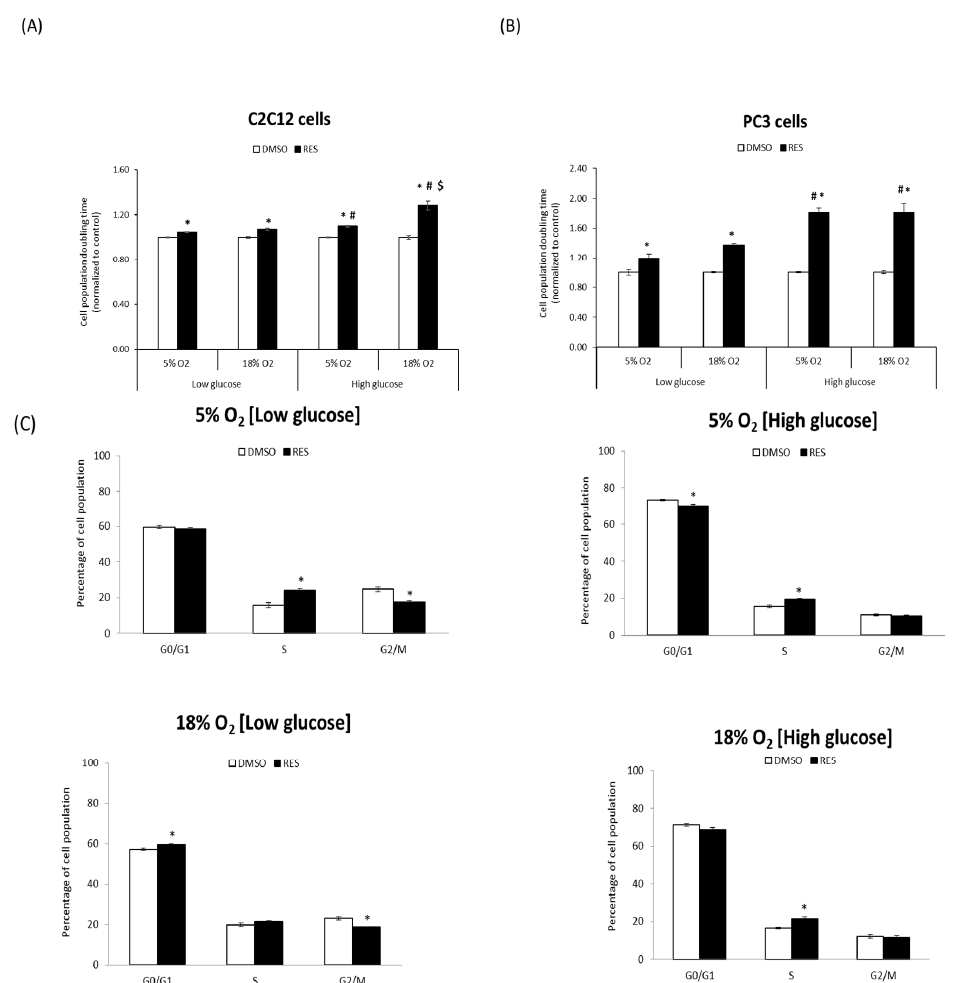
Figure 1. Media oxygen and glucose levels determine resveratrol’s effects on cell growth. Cell doubling time was measured following 48 h treatment with either Resveratrol (RES) (10 µ M; filled bars) or vehicle control (DMSO; open bars). C2C12 ( A ) and PC3 ( B ) cells were cultured at either 5% O 2 or 18% O 2 in either low (5 mM) or high (25 mM) glucose Dulbecco’s Modified Eagles Medium (DMEM). ( C ) Distribution of C2C12 cells in different cell cycle stages was determined by flow cytometry. Data shown are means ± SEM of at least 3 independent experiments with n = 24 for cell doubling time ( A , B ) and n = 12 for cell cycle measurements ( C ). ‘*’ represents differences between RES-treated and DMSO-treated cells, p < 0.05. ‘#’ represents differences between low and high glucose levels, p < 0.05. ‘$’ represents differences between low and high oxygen